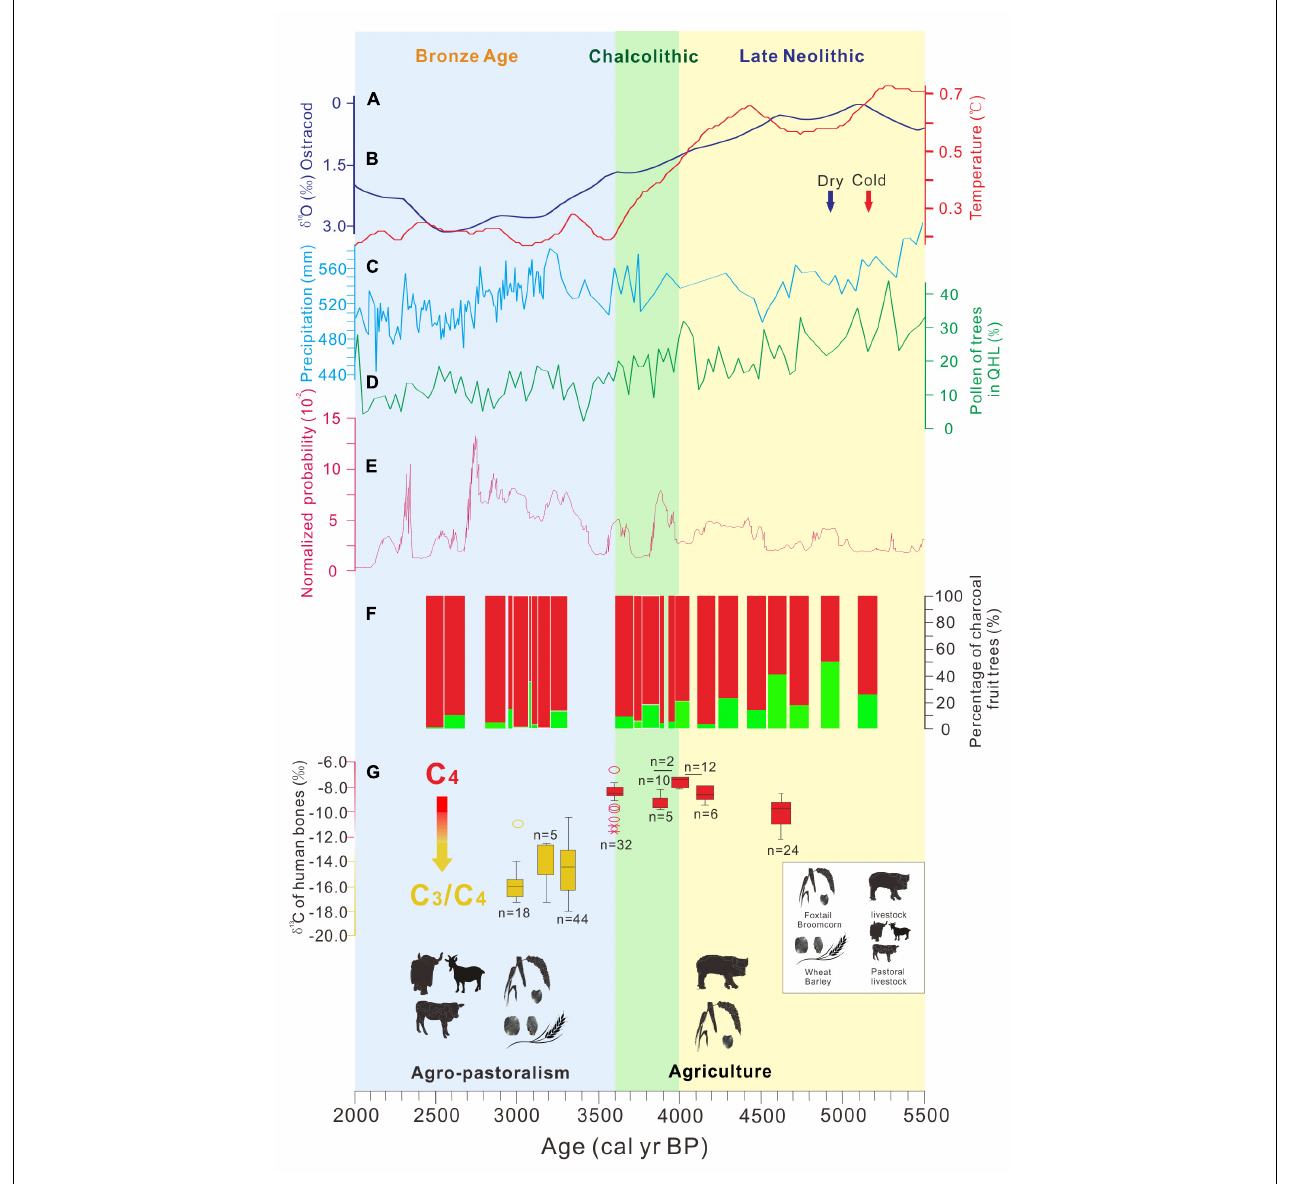
FIGURE 6 | Relationships between climate change, human subsistence, and proportions of fruit trees. (A) Quantitative reconstruction of Holocene temperature changes in the Northern Hemisphere (Marcott et al., 2013); (B) results of stable oxygen isotope measurements performed on ostracod values in sediment cores of Lake Qinghai (Liu X. Q. et al., 2007); (C) quantitative reconstruction of Holocene precipitation changes in northern China (Chen et al., 2015b); (D) pollen record of trees in sediment cores of Lake Qinghai (Liu et al., 2002); (E) normalized probability from radiocarbon dates of archeological sites in the NETP (5,500–2,000 BP); (F) proportions of fruit trees in the investigated sites in the NETP (green rectangles); (G) stable carbon isotope ratios ( δ 13 C) of human bones in the NETP and the adjacent Chinese Western Loess Plateau (Chen et al.,